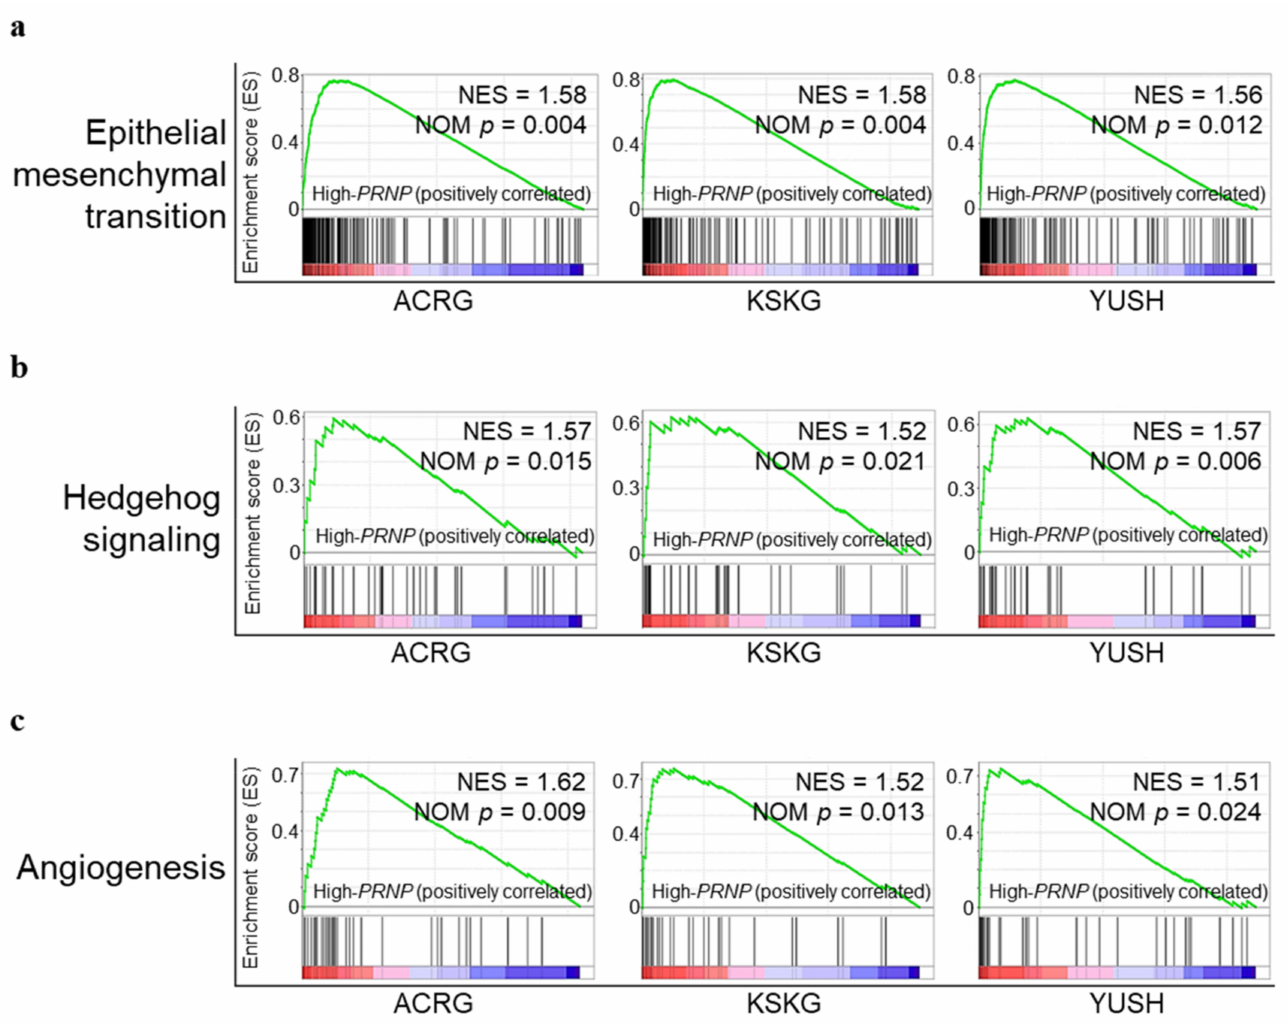
Figure 3. GSEA comparing high- PRNP and low- PRNP expression groups in three Korean GC cohorts (ACRG, KSKG, and YUSH). Enrichment plot shows important pathways identified using GSEA. ( a ) GSEA indicated the enrichment of EMT-related genes in Korean GC with high PRNP expression. ( b ) GSEA showed the enrichment of Hedgehog signaling-related genes in Korean GC with high PRNP expression. ( c ) GSEA indicated the enrichment of angiogenesis-related genes in Korean GC with high PRNP expression. NES, normalized enrichment score; NOM p , normalized p